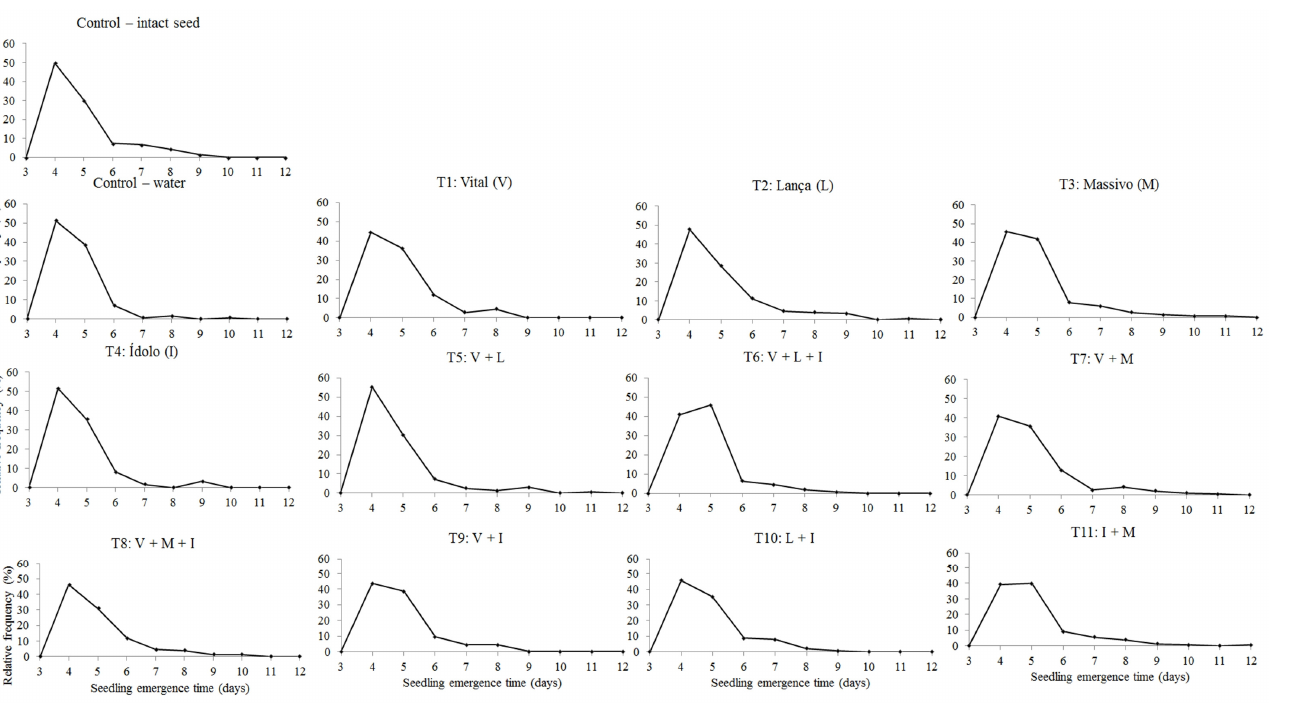
Figure 1. Distribution of relative frequency of soybean NS7667 IPRO seedling emergence in the field from different seed treatments. Jataí, GO, Brazil, 2022.